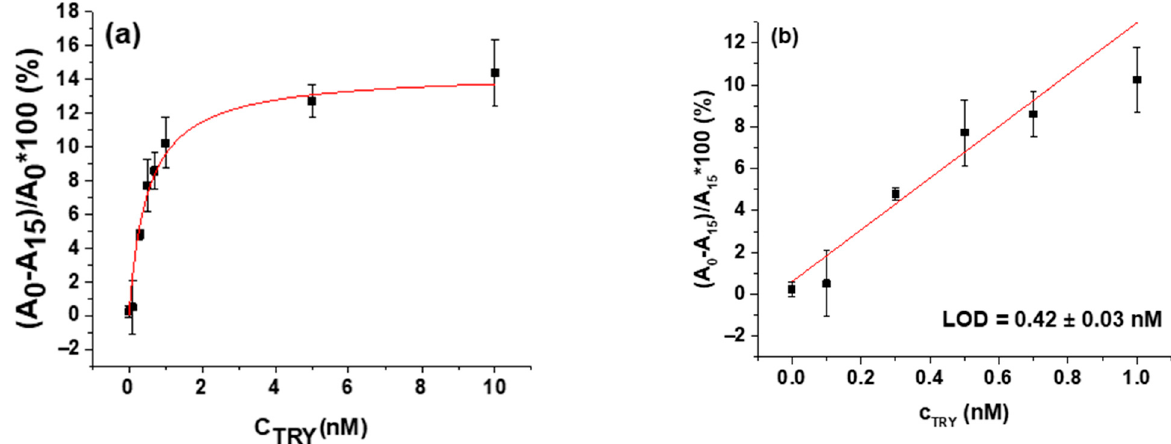
Figure 8. Calibration plots of colorimetric assay. ( a ) Changes in relative values of absorbance after β -casein and MCH functionalized gold nanoparticles (AuNPs/MCH- β -casein) exposure to trypsin (A 0 —exposure time 0 min, A 15 —exposure time 15 min.) vs. concentration of trypsin (C TRY ). Symbols are experimental data, and the red line is the best fit of Equation (3). ( b ) Linear part of the calibration curve for calculation of the limit of detection (LOD). Values are means ± SD ( n = 3). Red line is the linear regression fit.